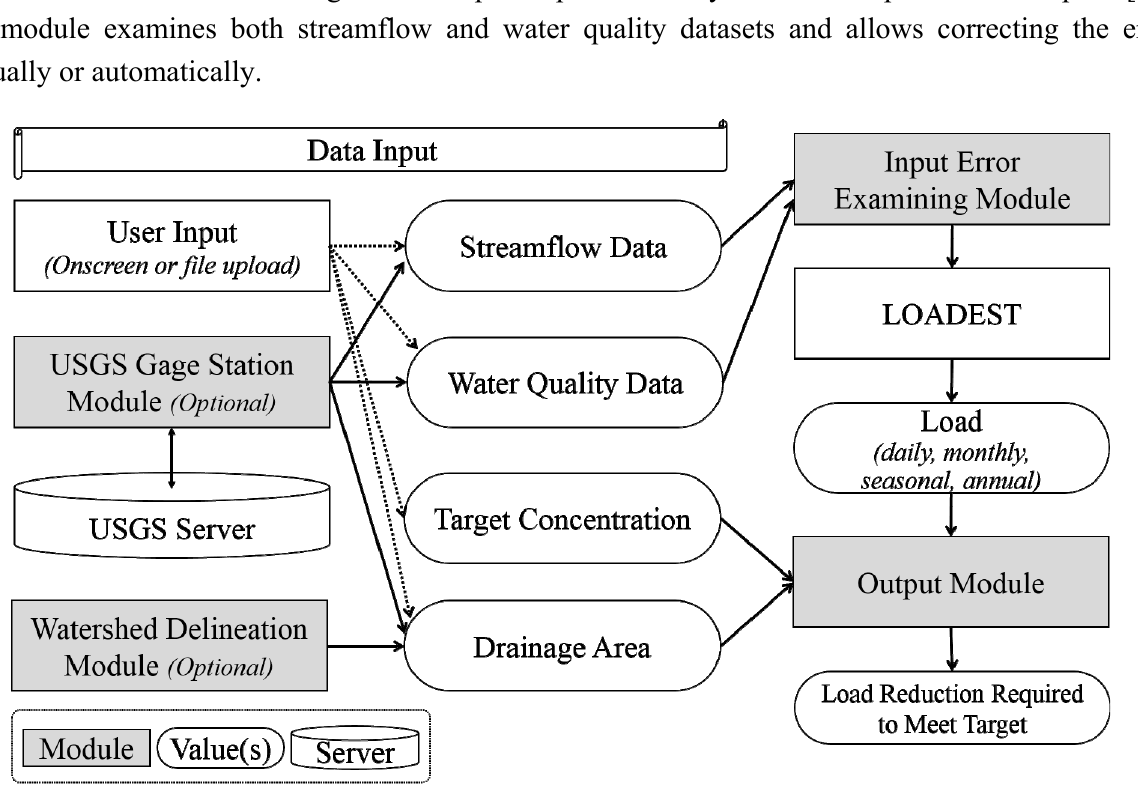
Figure 2. Schematic depicting LOADEST WEB to provide model inputs from